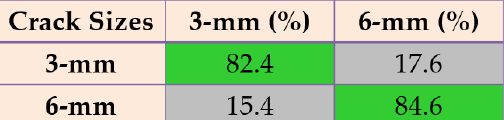
Figure 24. The average of crack size (3 mm and 6 mm) diagnosis using the combination of ALSGL- SB and SVM approach for all abnormal conditions.